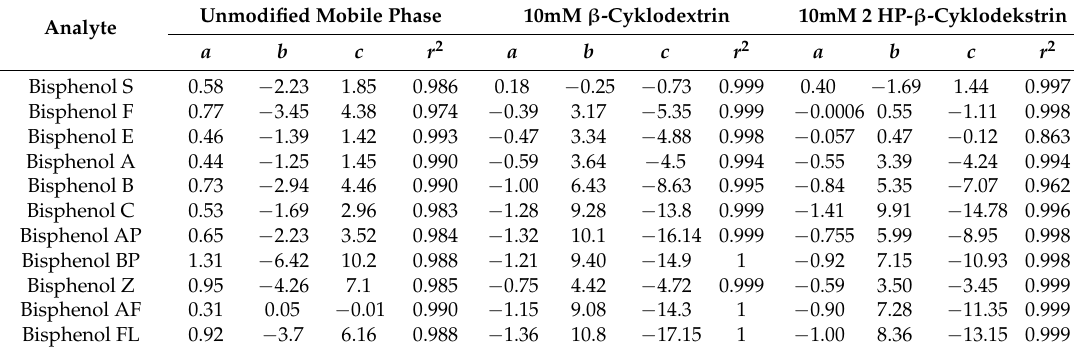
Table 2. Values of non-linear regression coefficients and determination coefficient ( r 2 ) for the equation in the form ln k = ax 2 + bx+ c (where x = 1000/T) for substances chromatographed on a 10 cm LC-18 column and mobile acetonitrile/water phases (35%, v / v ) without a macrocyclic modifier and with the addition of β -cyclodextrin and hydroxypropyl- β -cyclodextrin, calculated on the basis of the data presented in Table 1. Unmodified Mobile Phase 10mM β Analyte